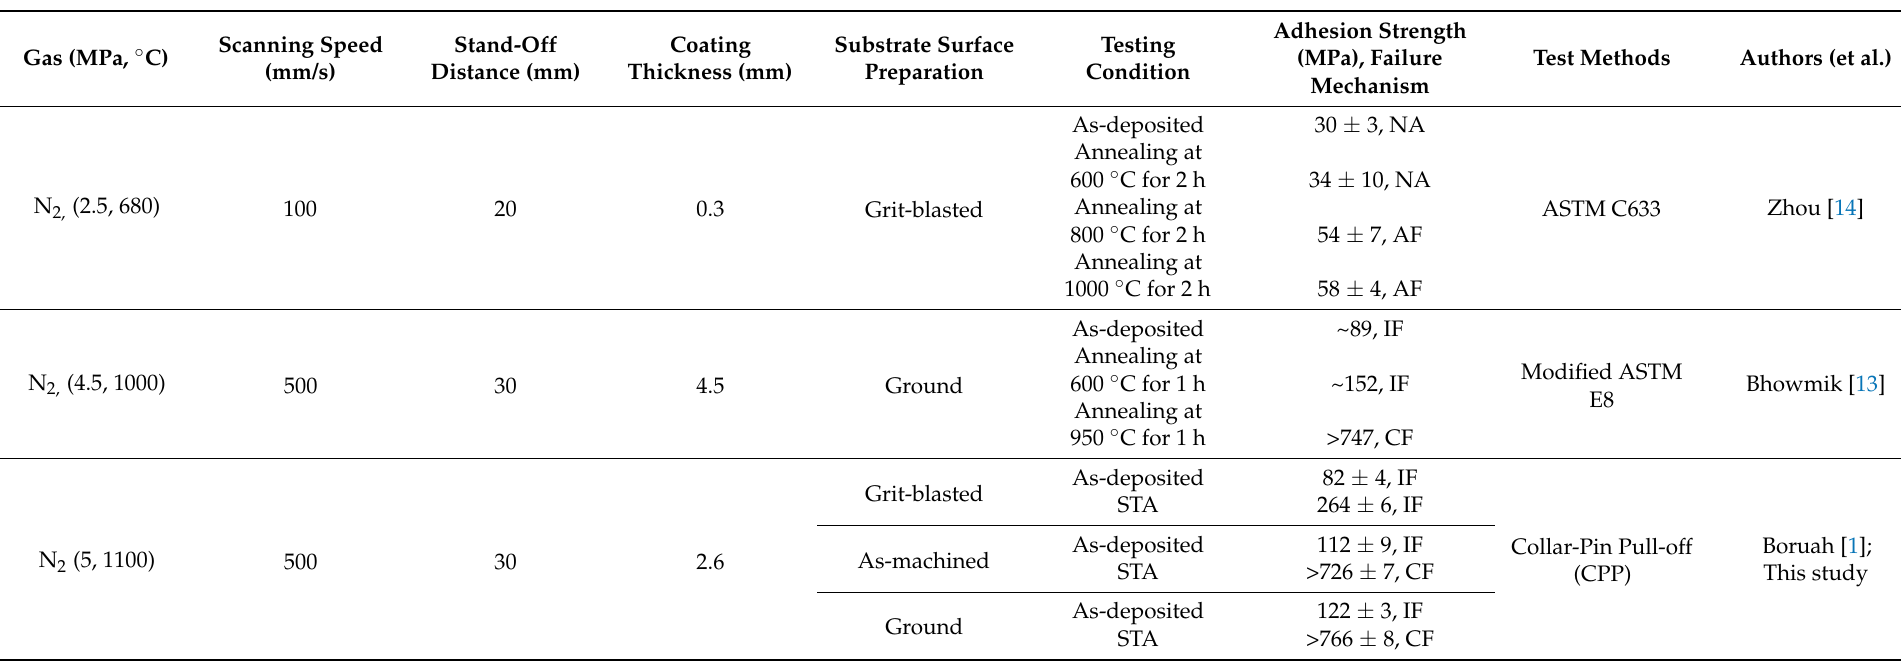
Table 4. Effect of post-deposition thermal treatments on the adhesion strength of CS Ti6Al4V deposited on Ti6Al4V substrate: literature versus this